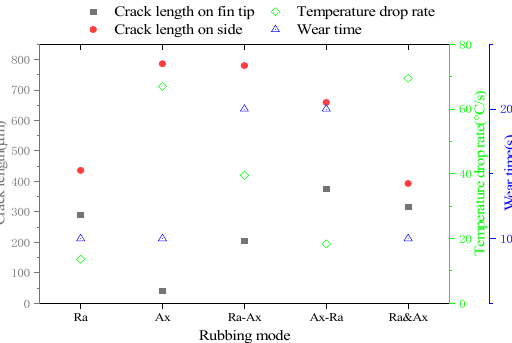
Figure 13. Length of cracks on the fin tip and